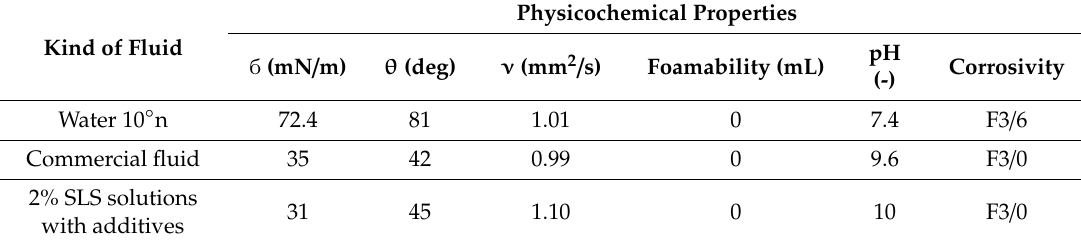
Table 2. Physicochemical properties of surfactant working fluids (SWFs) intended for stand and operational tests.